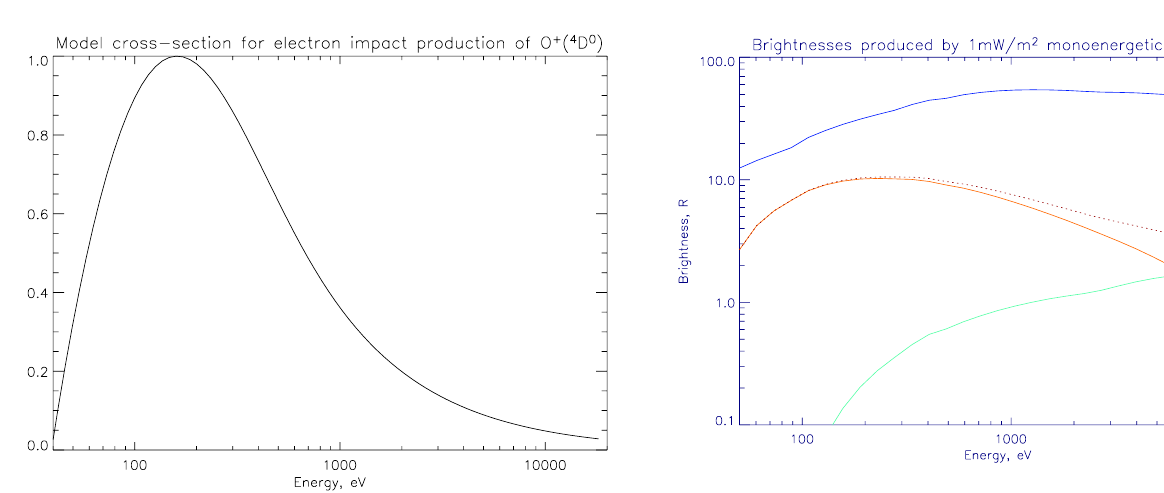
Fig. 13. Model shape of the cross section for production of the O + 4 D 0 state from atomic oxygen.